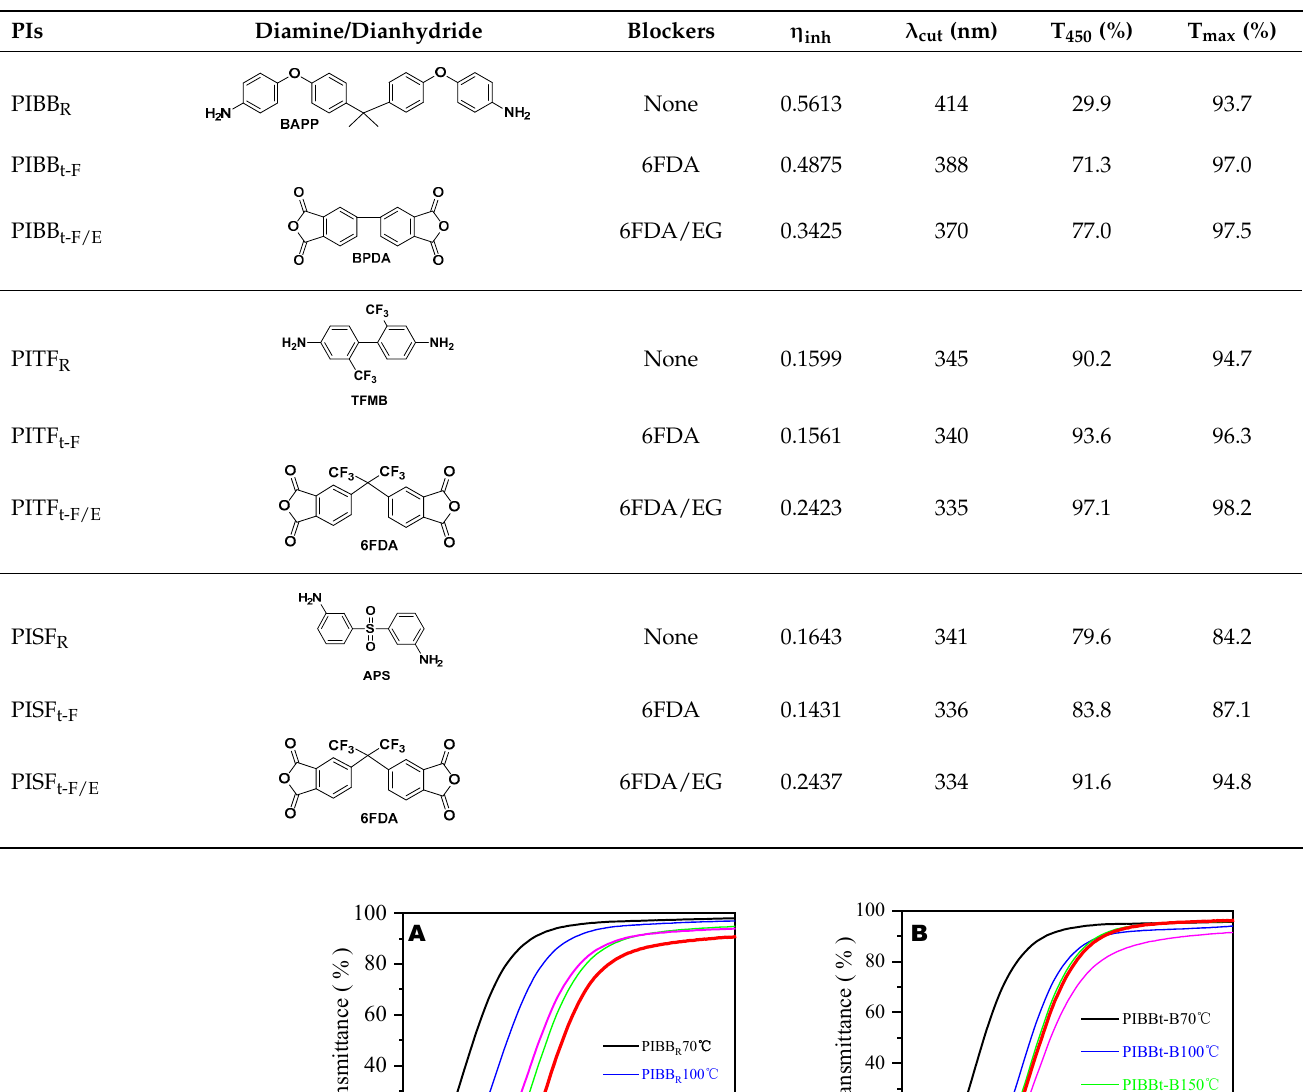
Table 2. Optical properties of PIBBs, PITFs, and PISFs films.